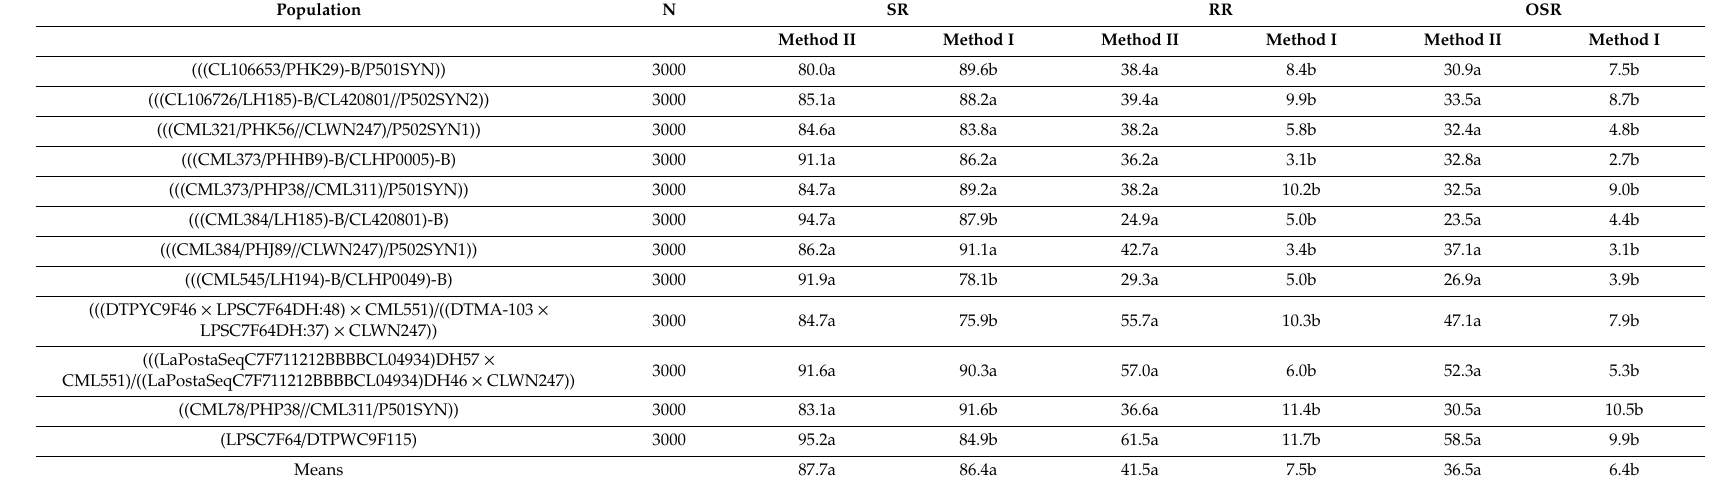
Table 7. Validating the e ffi ciency of Method II versus Method I across multiple